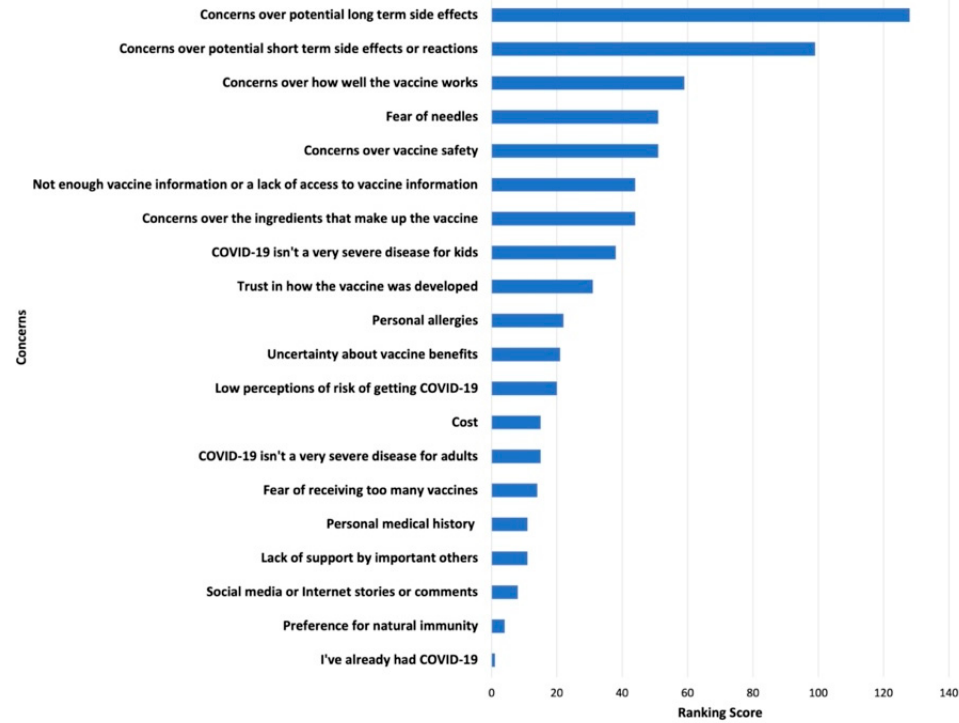
Figure 2. Top Adolescent Concerns for Vaccinating against COVID-19.